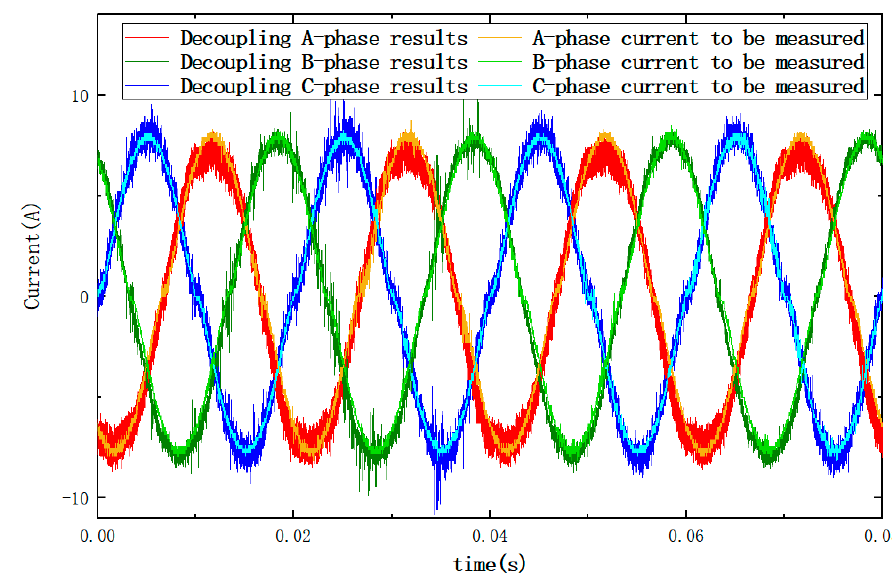
Figure 11. Reconstruction current versus input current graph.